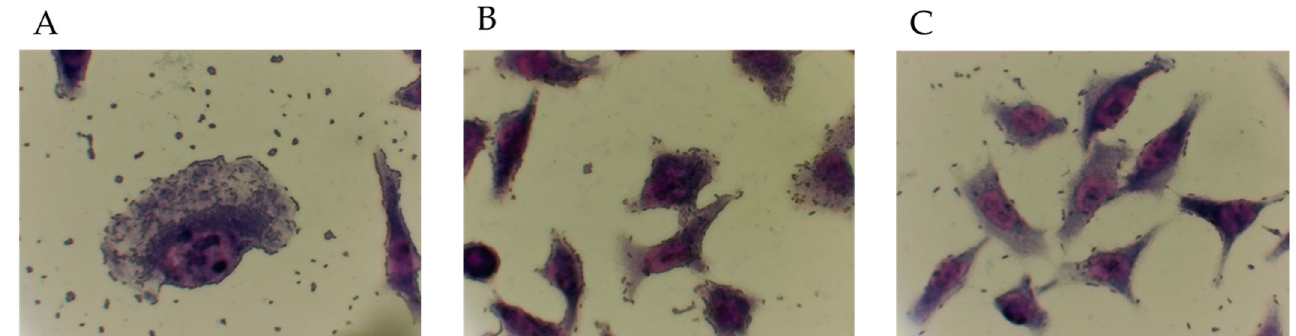
Figure 1. Adherence patterns identified in this study. ( A ), localized adherence (present in strains